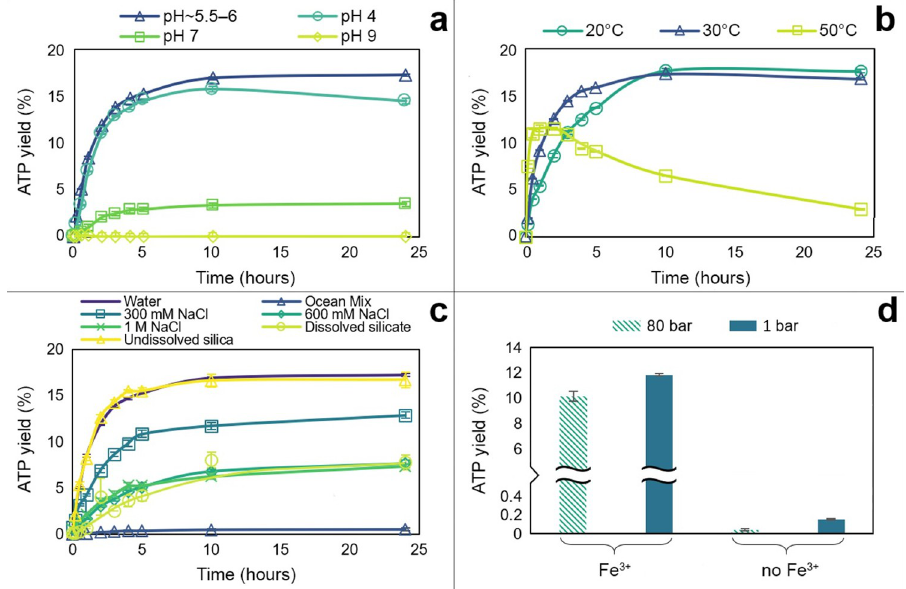
Fig 2. ATP synthesis by AcP and Fe 3+ at different conditions. ( a ) Effect of pH on reaction ADP (1 mM) + AcP (4 mM) + Fe 3+ (500 μ M) at 30˚C. The optimal pH of the reaction is approximately 5.5–6. Rate of reaction: 0.0079 μ M/s (optimal pH), 0.0074 μ M/s (pH 4), and 0.0011 μ M/s (pH 7). N = 3 ± SD. ( b ) Effect of temperature on reaction ADP (1 mM) + AcP (4 mM) + Fe 3+ (500 μ M), pH approximately 5.5–6. Rate of reaction: 0.0066 μ M/s (20˚C), 0.0079 μ M/s (30˚C), and 0.028 μ M/s (50˚C). N = 3 ± SD. ( c ) Comparison of ATP yield from the reaction ADP (1 mM) + AcP (4 mM) at 30˚C, pH approximately 5.5–6 in water (reaction ionic strength = 3.75 mM), a modern ocean mix (600 mM NaCl, 50 mM MgCl 2 , and 10 mM CaCl 2 , reaction ionic strength = 783.75 mM), 300 mM NaCl (reaction ionic strength = 303.75 mM), modern ocean concentration of NaCl (600 mM, reaction ionic strength = 603.75 mM), 1 mM NaCl (reaction ionic strength = 1.004 M), dissolved silicate (10 mM SiO 2 , reaction ionic strength = 123.75 mM), and suspended silica in water (50 mg). N = 3 ± SD. ( d ) Comparison of ATP yield from the reaction ADP (1 mM) + AcP (4 mM) at 30˚C and pH approximately 5.5–6 with and without Fe 3+ (500 μ M) at 80 bar (striped yellow) and at atmospheric pressure (1 bar, solid blue). N = 2 ± SD. The data underlying this figure can be found in Table D–G in S1 Data (sheet